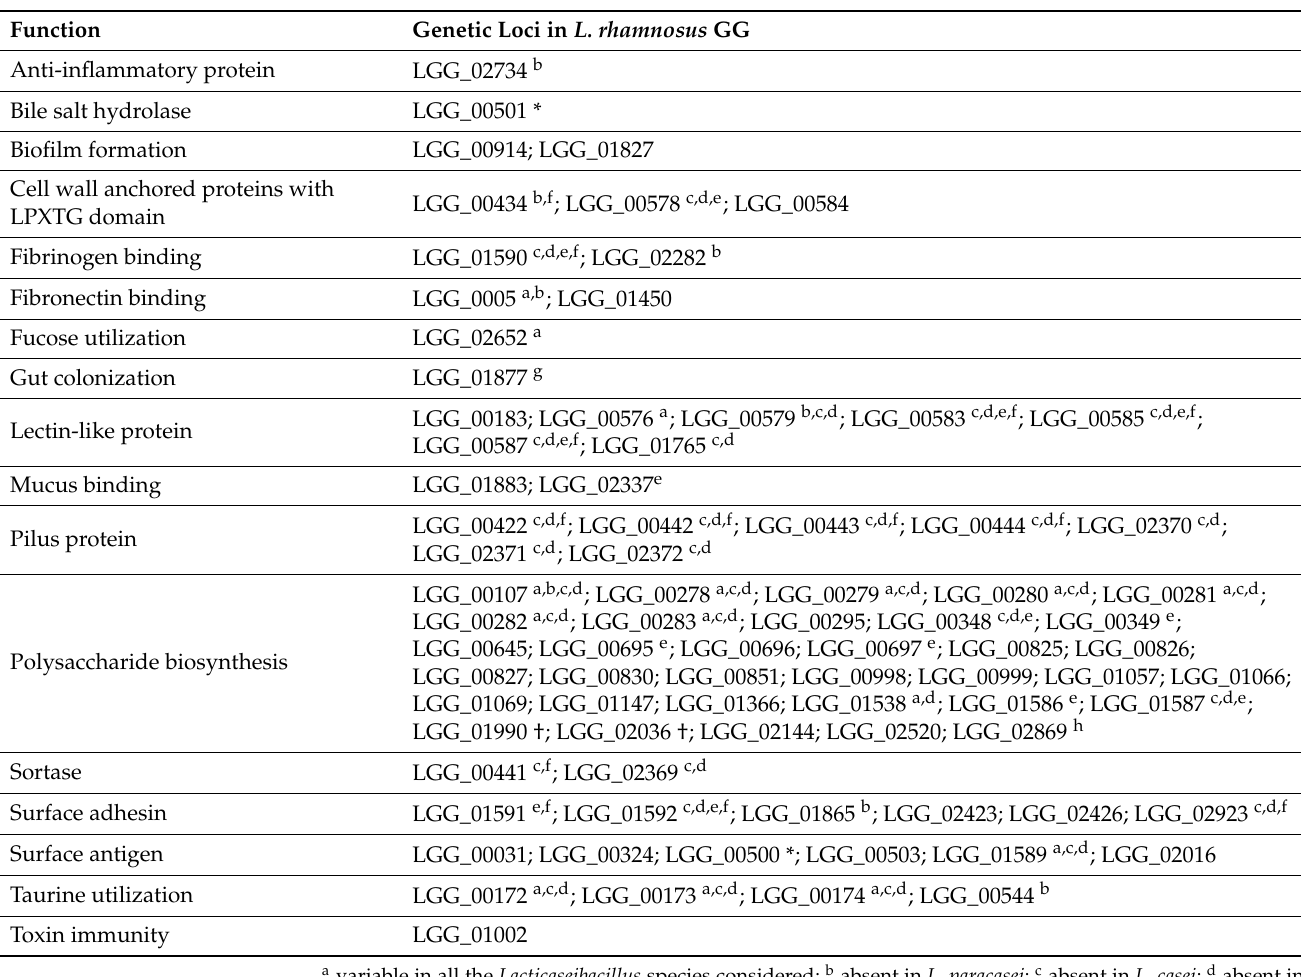
Table 1. Gene loci in the genome of L. rhamnosus GG encoding traits relevant for the capacity to exert probiotic properties separated on the basis of their functional